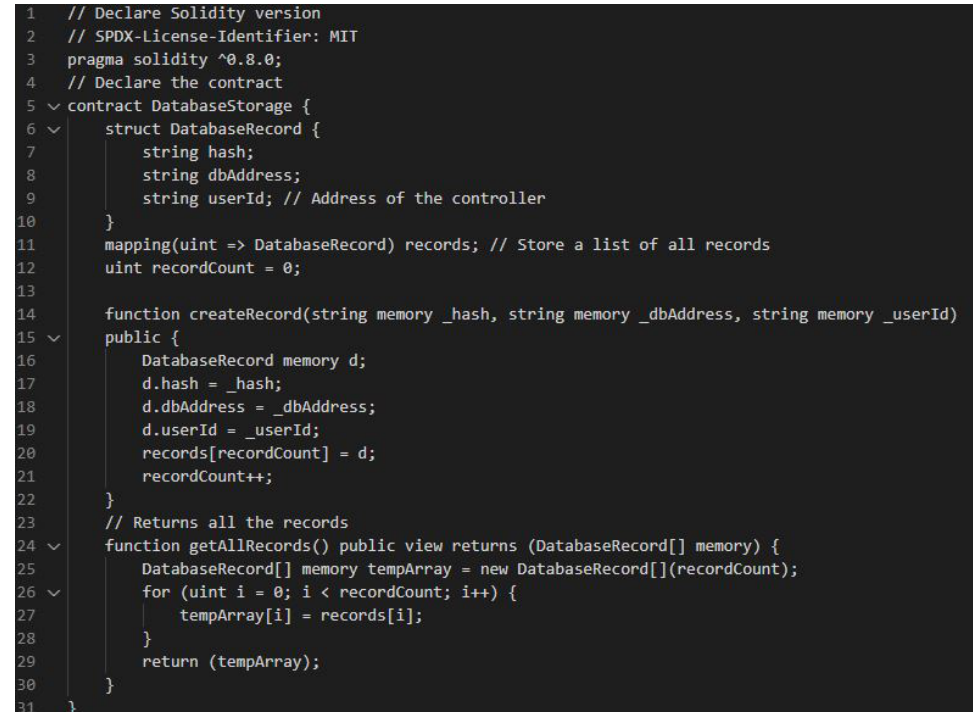
Figure 12. Smart